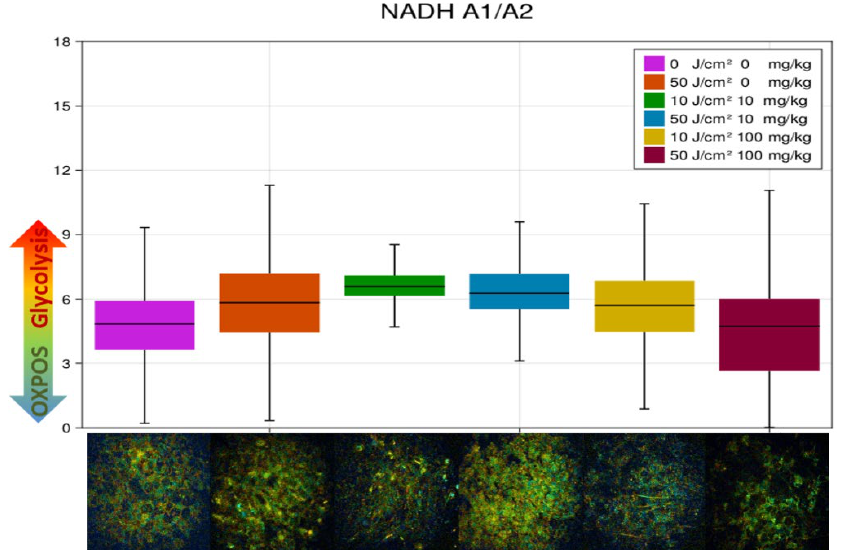
Figure 9. Phasor diagrams for time-resolved fluorescence images of tumor slices after ALA–PDT in the spectral bands of NADH ( a ), flavins ( b ) and PpIX ( c ). The phasor diagram for the time-resolved fluorescence in the PpIX spectral range for After a high dose of irradiation, the presence of M2-polarized macrophages in tissues tissues 3 days after PDT demonstrates the remaining high presence of PpIX and PpIX decreases. photoproducts (Figure 9c). In cases of low-dose laser irradiation (10 J/cm 2 ), the long life- time corresponding to PpIX is more pronounced. When the laser dose is increased to 50 J/cm 2 , the fluorescence lifetime shifts toward a short lifetime that is more consistent with the photoproducts of PpIX.